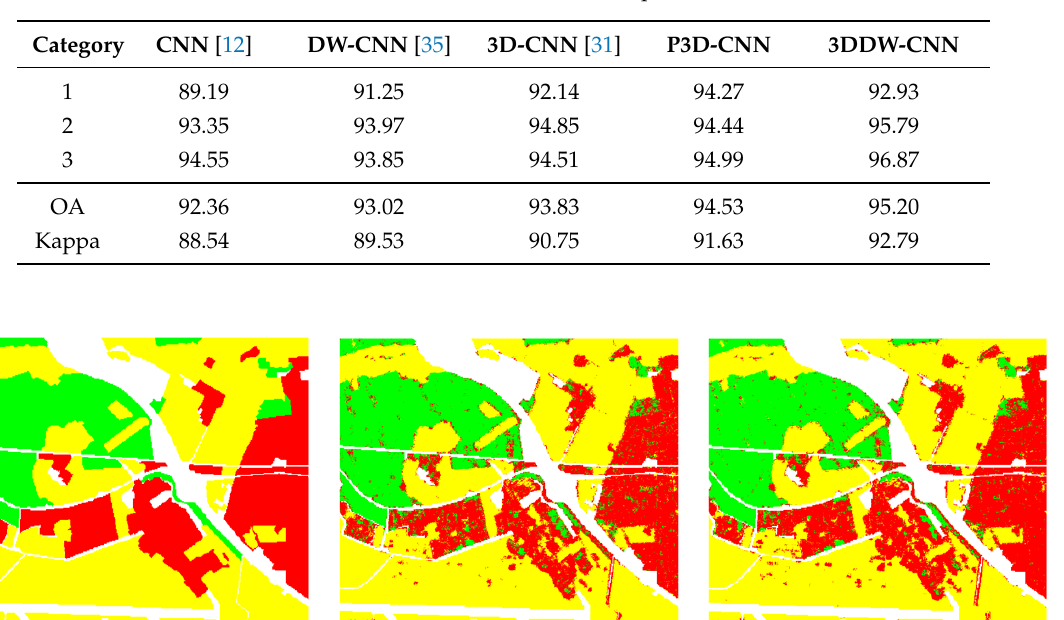
Table 6. Classification results (%) on ESAR Oberpfaffenhofen dataset.